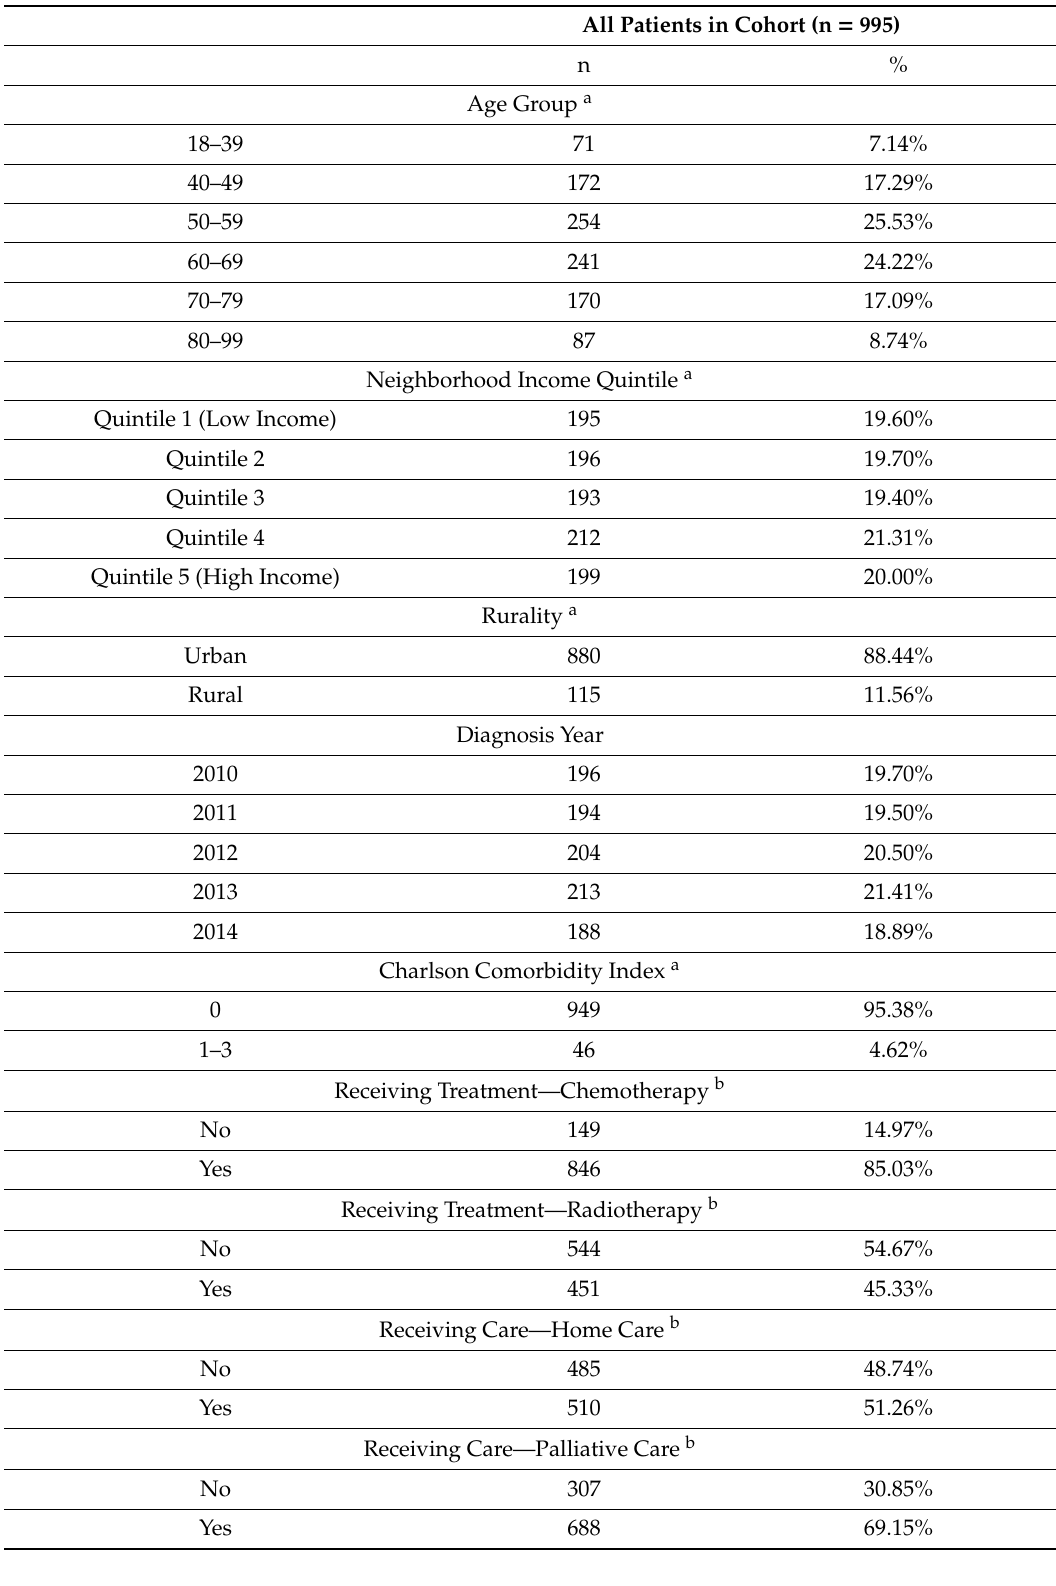
Table 1. ESAS assessments per